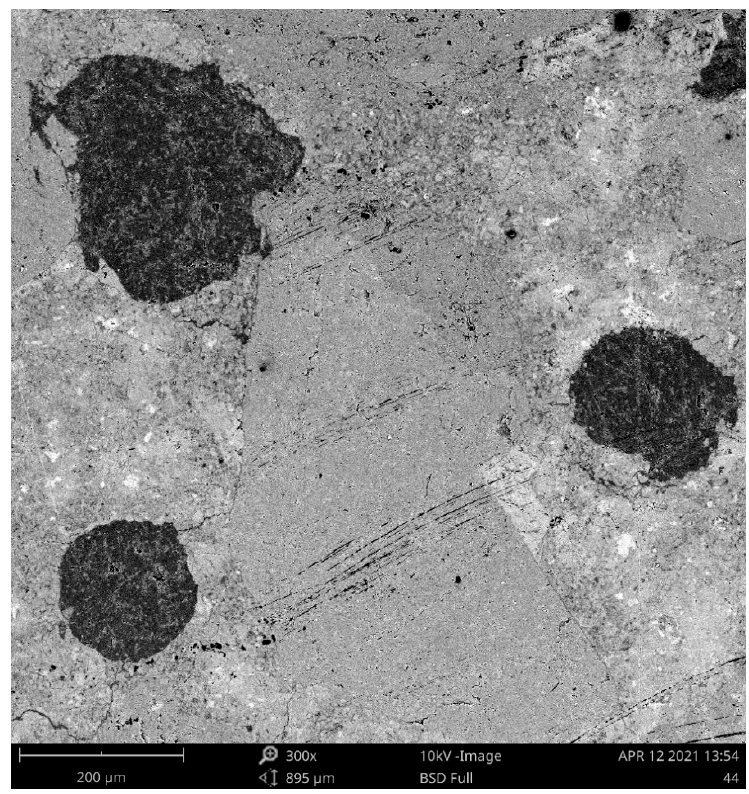
Figure 2. SEM image of SAP particles embedded in a mortar structure (A3 mixture).